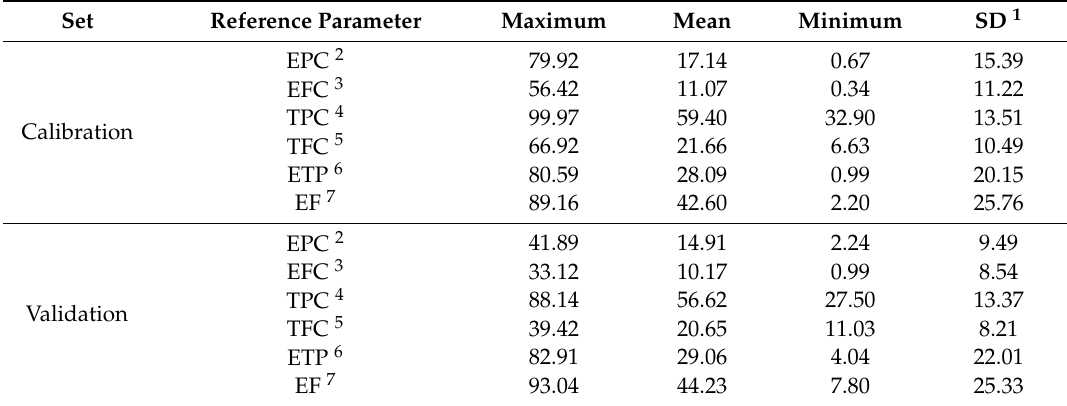
Table 1. Main statistical descriptors for reference parameters in calibration and validation sets. Set Reference Parameter Maximum Mean